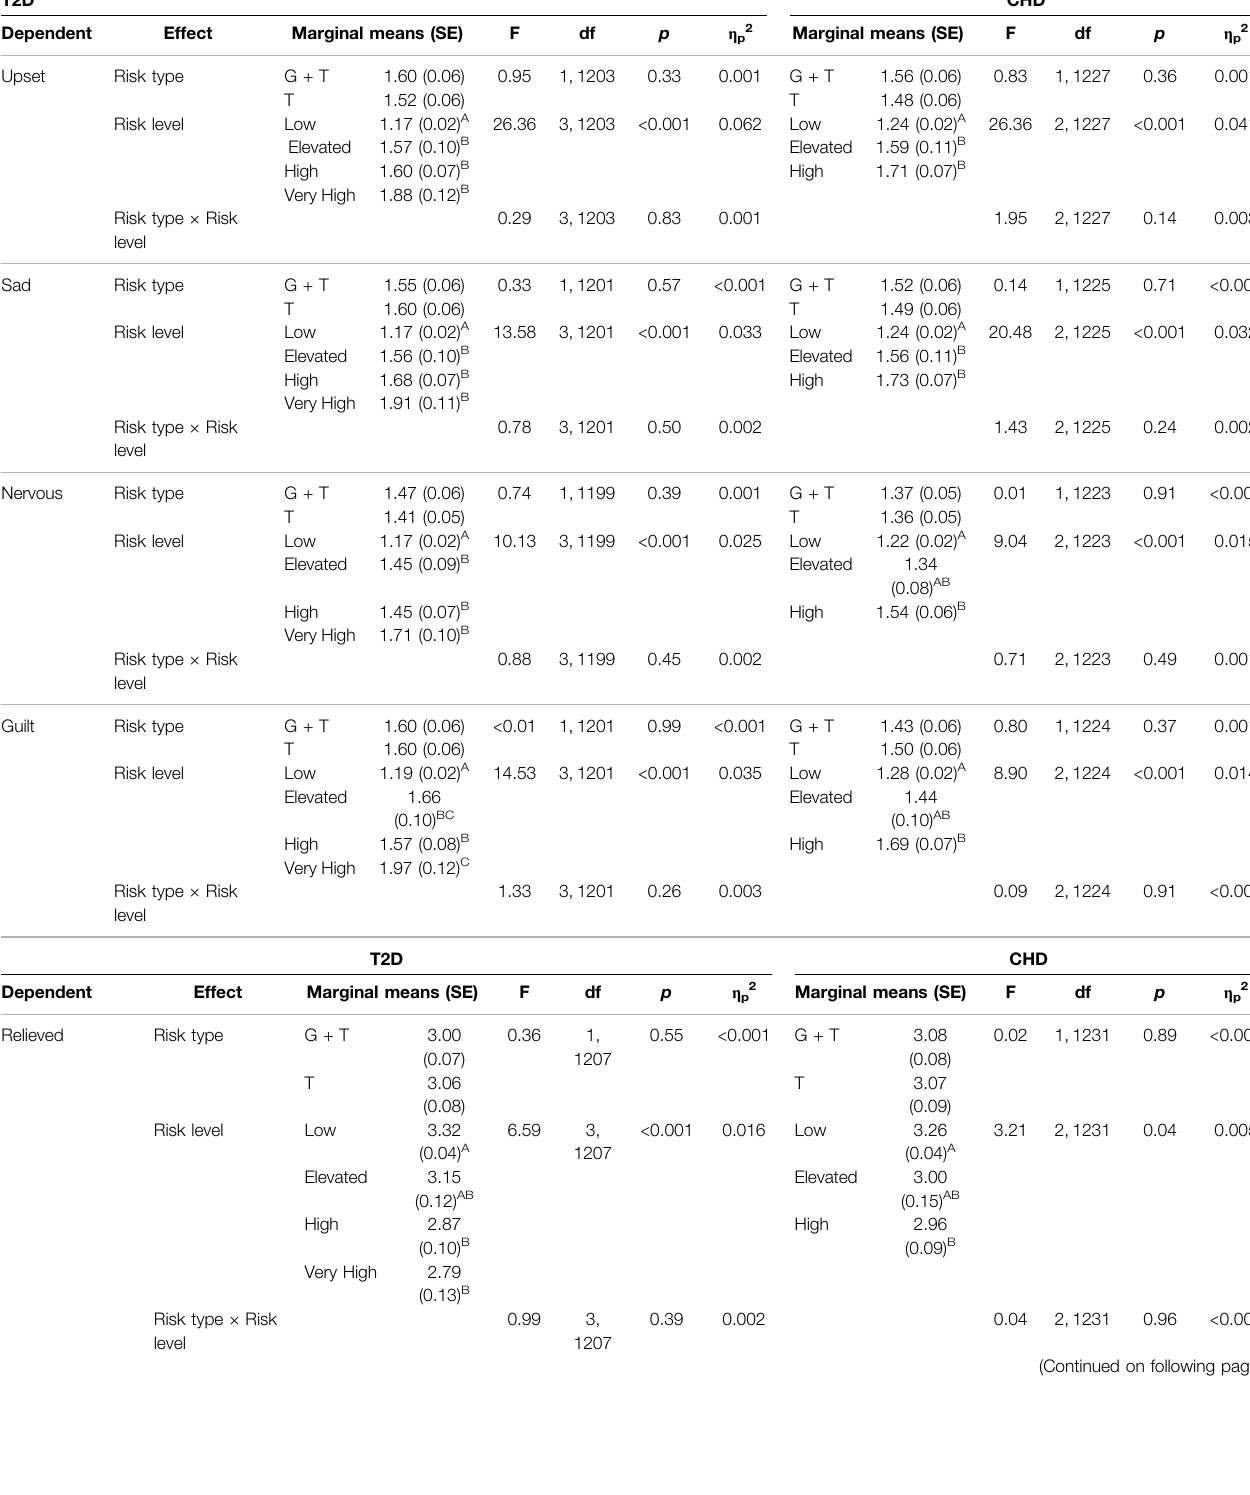
TABLE 3 | Analysis of variance main effects and interactions: Emotional reaction to the test results concerning T2D and CHD risk. T2D CHD Dependent Effect Marginal means (SE) F df p η p2 Marginal means (SE) F df p η p2 Upset Risk type